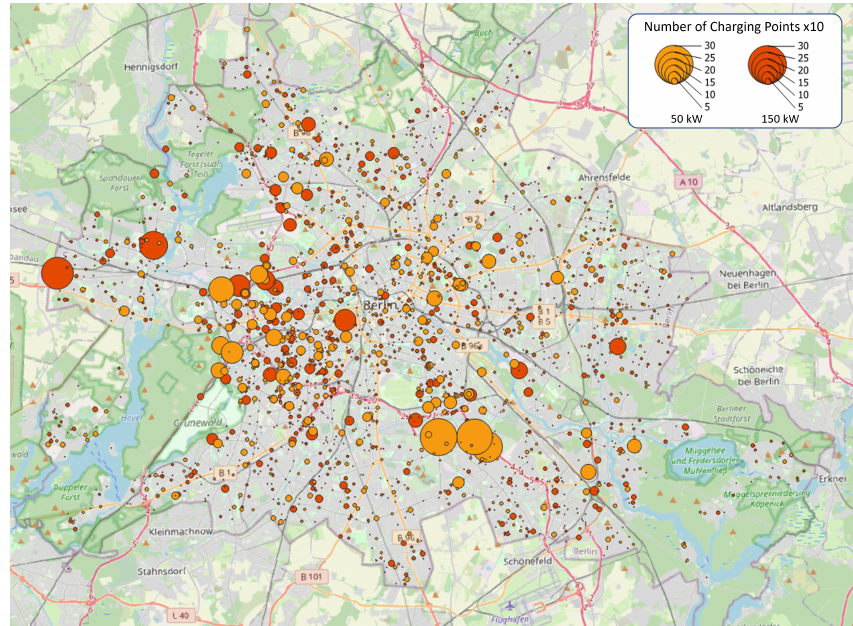
Figure 11. Spatial distribution of public charging infrastructure in top-edge